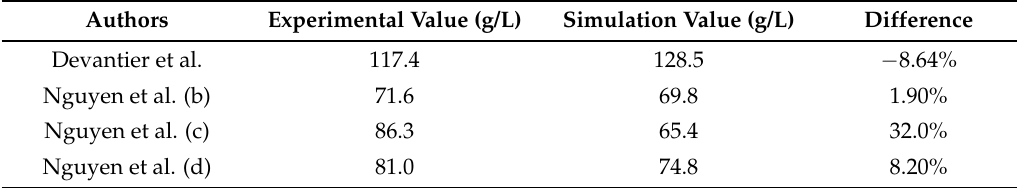
Table 5. Final ethanol concentration values (g/L) for experimental and simulated data.